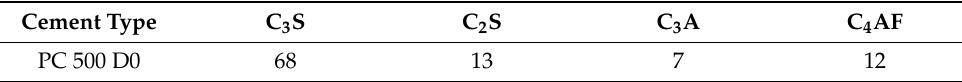
Table 5. Mineralogical composition of cement.